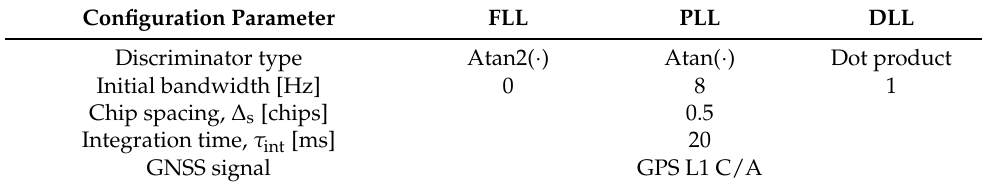
Figure 6. Photo of the GOOSE SBC receiver @Fraunhofer IIS/Paul Pulkert. Table 1. Configuration of tracking stage in GOOSE